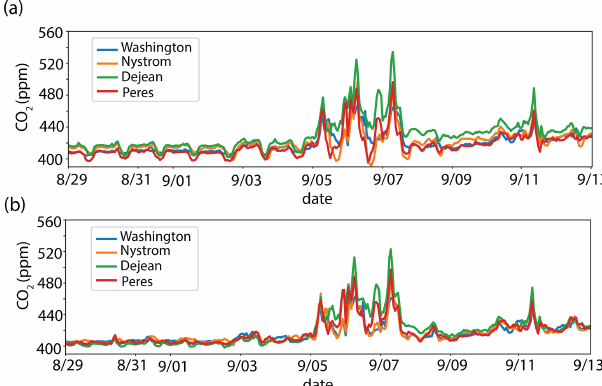
Figure 7. CO 2 mixing ratios during and before 2020 September wildfires at four adjacent sites in Richmond without (a) and with (b) temperature correction.